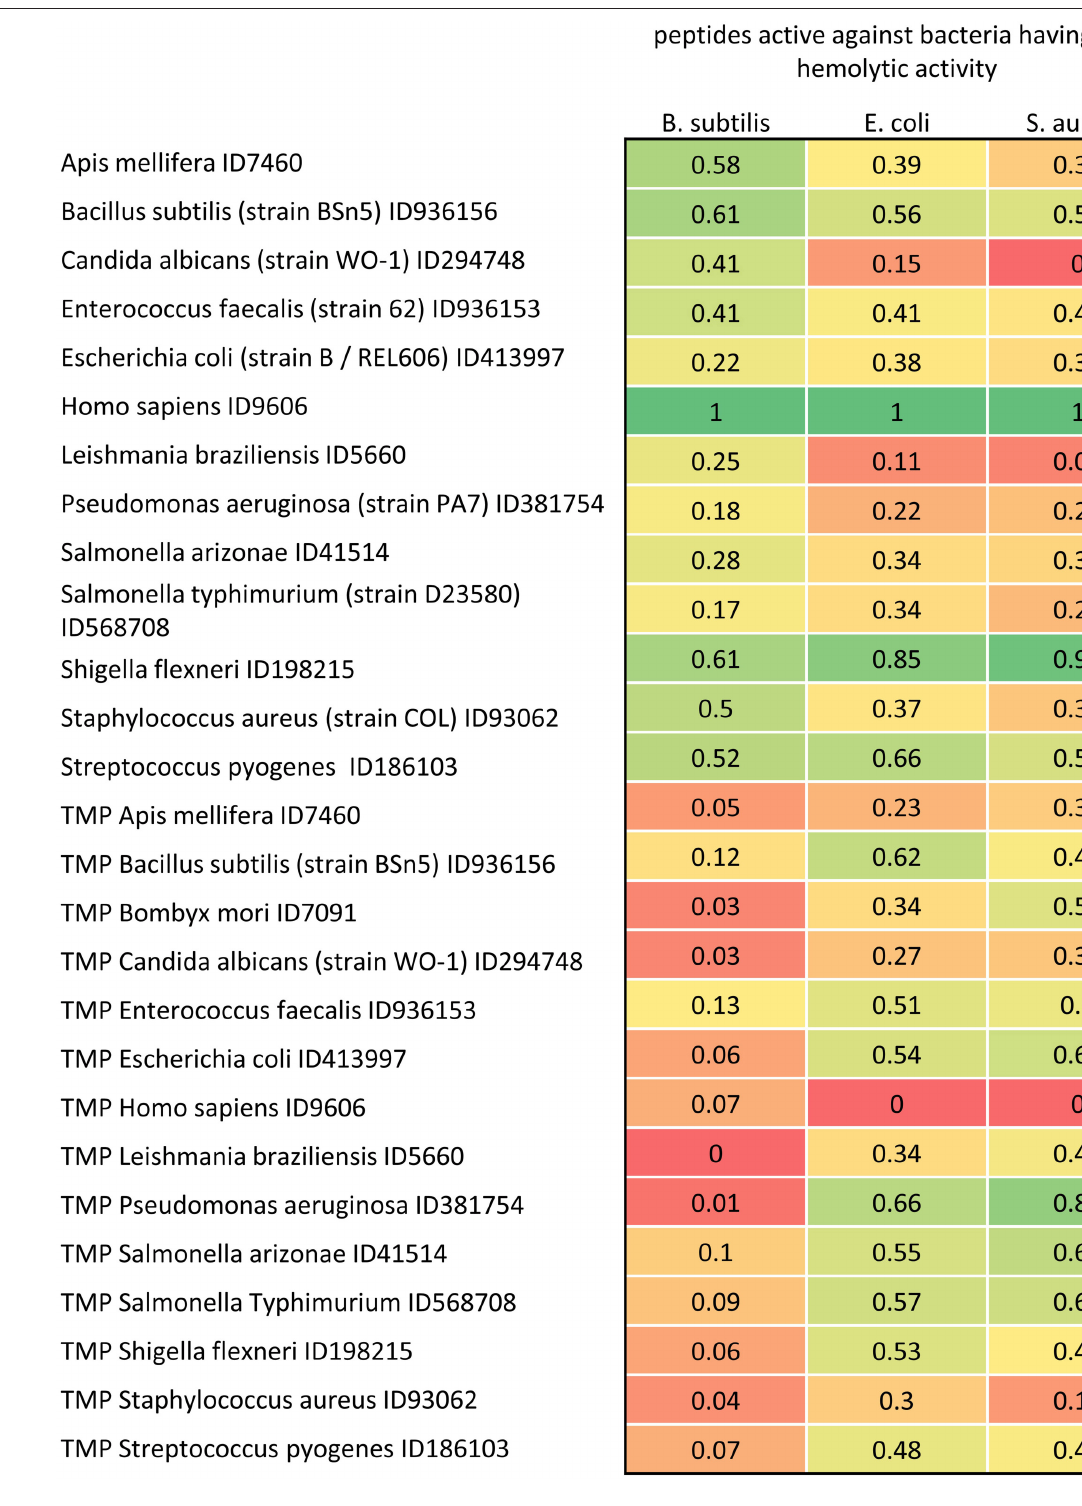
FIGURE 7 | Distance matrix between sets of AMP having low hemolytic activity (MIC 0 > 200 µ M) active against B. subtilis , E. coli and S. aureus (with MIC 0 < 50 µ M), and proteome and TMP sets of 13 representative organisms. The distances are scaled from 0 (farthest) to 1 (closest).